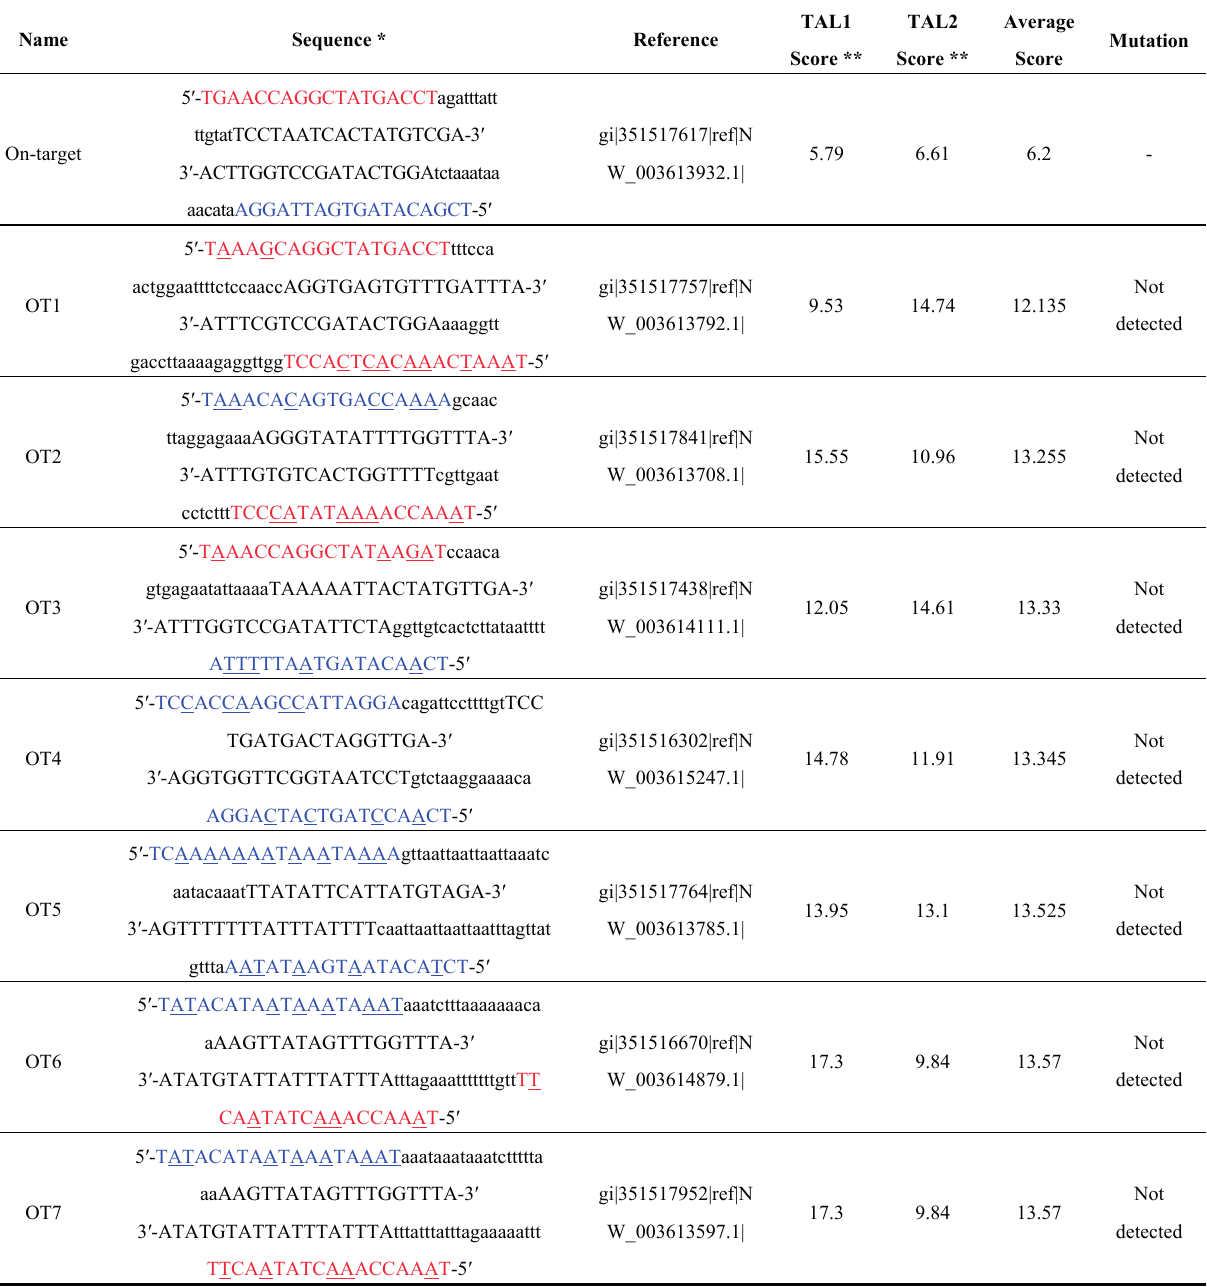
* Red and blue letters indicate the left and right TALEN target sequences, respectively. Lowercase letters indicate spacer sequence. Mismatches are underlined; ** TAL1 and TAL2 scores were calculated by the Paired Target Finder tool